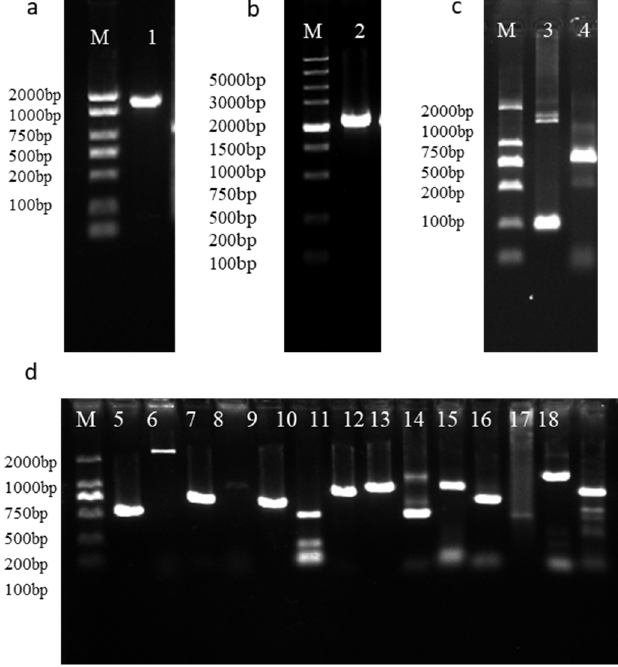
Figure 7. PCR amplification of TFs related to MrFPS ( a – c ) and MrBBS ( d ). Lane M, markers; lane 1, MrMYB1 ; lane 2, MrAP22 ; lane 3, MrWRKY1 ; lane 4, MrAP21 ; lane 5, MrMYB2 ; lane 6, MrMYB3 ; lane 7, MrMYB4 ; lane 8, MrMYB5 ; lane 9, MrMYB6 ; lane 10, MrAP23 ; lane 11, MrAP24 ; lane 12, MrAP25 ; lane 13, MrAP26 ; lane 14, MrAP27 ; lane 15, MrAP28 ; lane 16, MrWRKY2 ; lane 17, MrWRKY3 ; lane 18, MrWRKY4